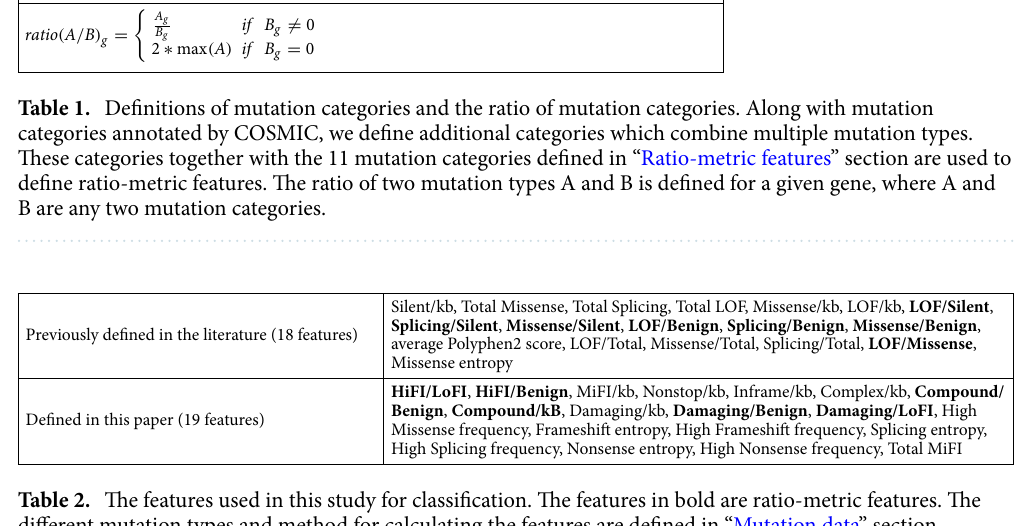
Table 2. The features used in this study for classification. The features in bold are ratio-metric features. The different mutation types and method for calculating the features are defined in “Mutation data” section.